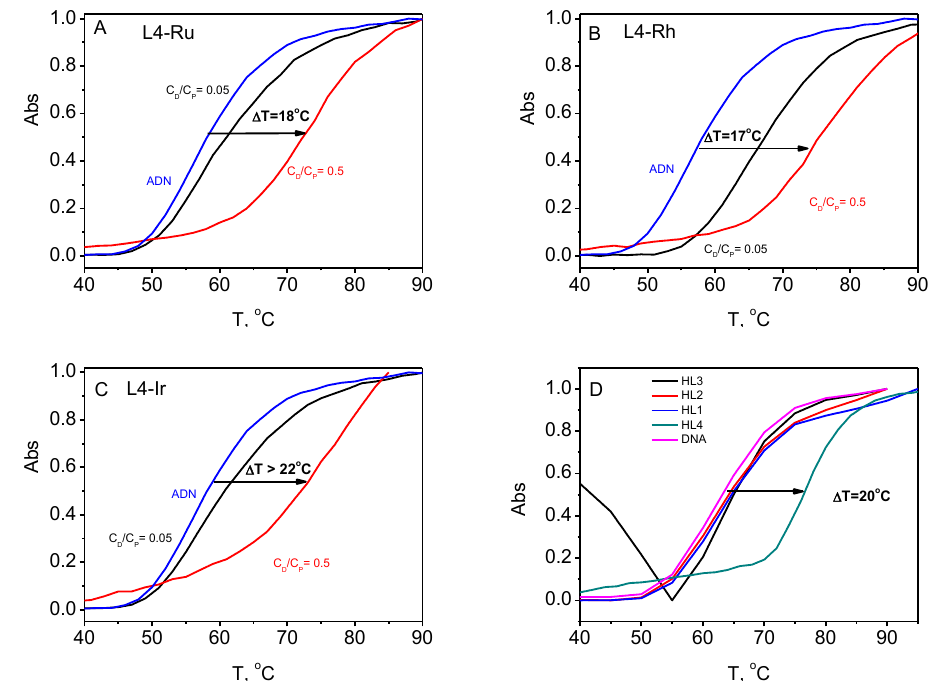
Figure 5. Melting profiles for ( A ) L4-Ru /DNA, ( B ) L4-Rh /DNA, ( C ) L4-Ir /DNA and ( D ) proligands HL1 – HL4 with DNA at C D /C P = 0.5. C P = 5.7 × 10 −5 M. C D = analytical concentration of the drug. C P = analytical concentration of DNA.